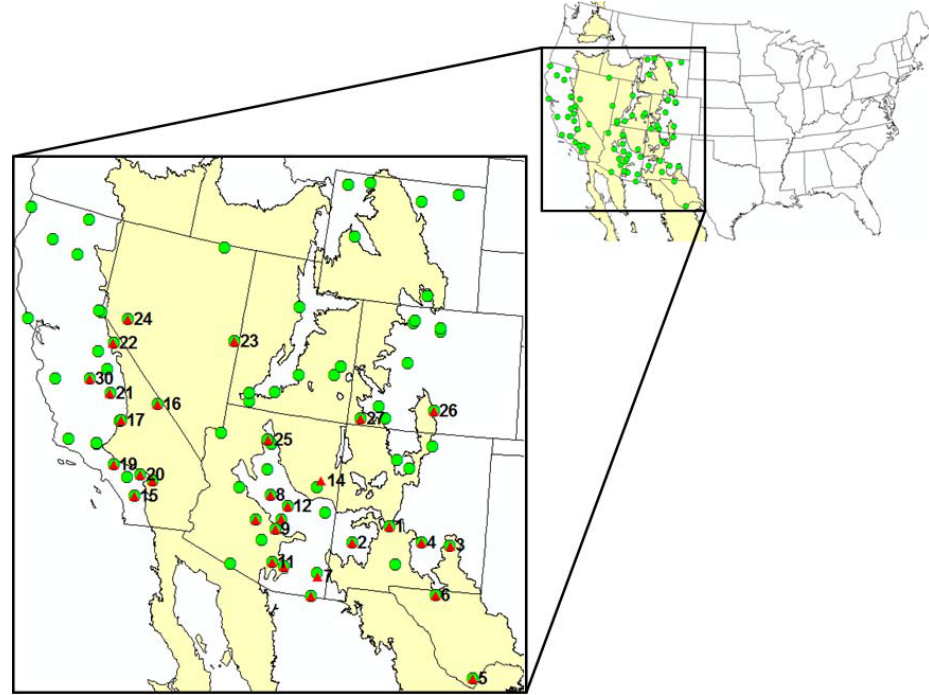
Fig. 1. Locations of the 68 selected IMPROVE monitors from which the aerosol observation data are used in this study. The 30 sites (marked in red) indicate the locations where at least one local dust storm has been identified between 2000 and 2007 using the approach proposed in this work. The background is the area classified as arid or semi-arid